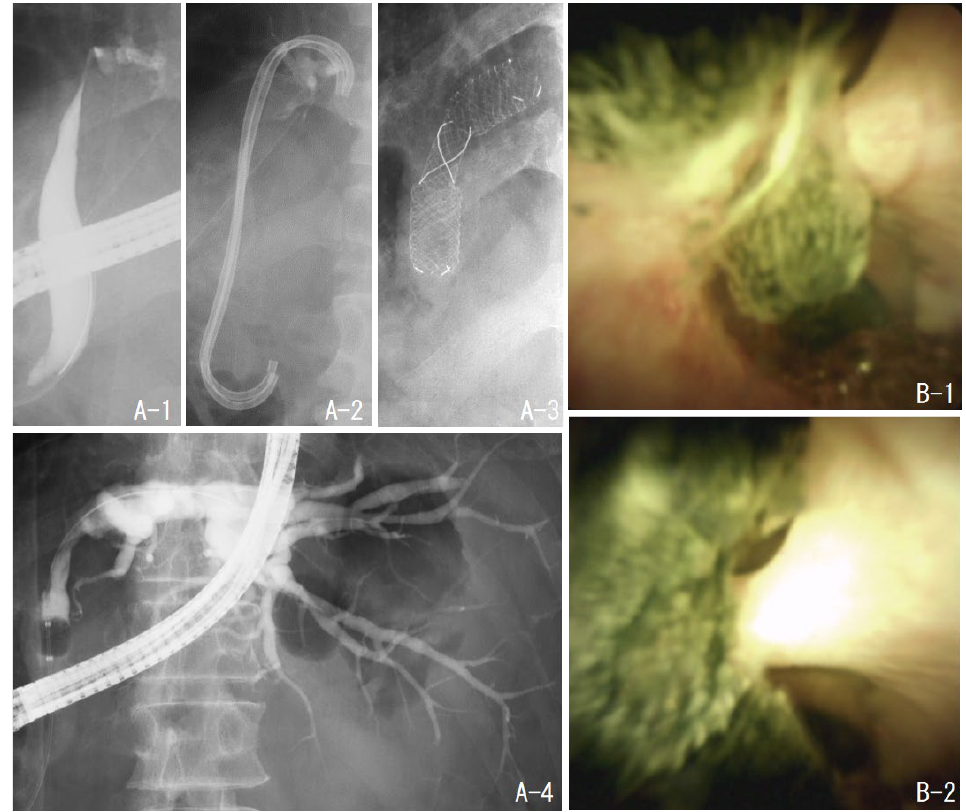
Figure 2. Case 2. The patient had a stenosis of the left hepatic duct after the right hepatectomy ( A-1 ). There were multiple stones upstream of the stenosis ( B-1 , B-2 ). The stones were removed by electrohydraulic shockwave lithotripsy under oral cholangioscopy. However, the stenosis was not dilated by the plastic stent ( A-2 ); hence, a self-expandable metallic stent was placed ( A-3 ). One month later, the stent was removed, and cholangiography showed improvement of the stenosis ( A-4 ).